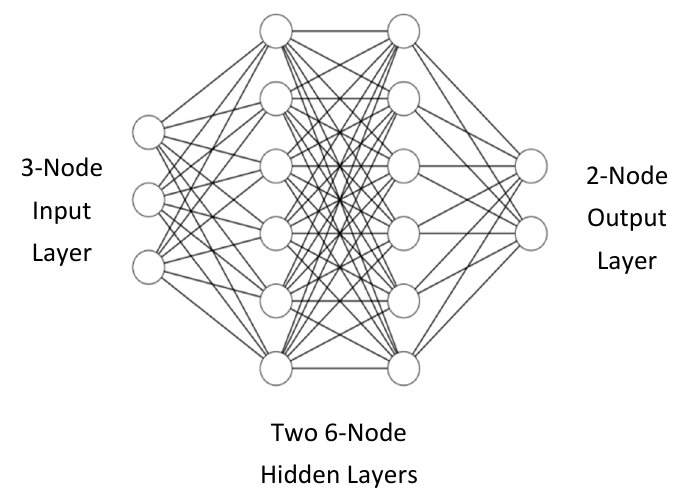
Figure 8. A 3-6-6-2 artificial neural network (ANN) consisting of a 3-node input layer, two 6-node hidden layers, and a 2-node output layer.